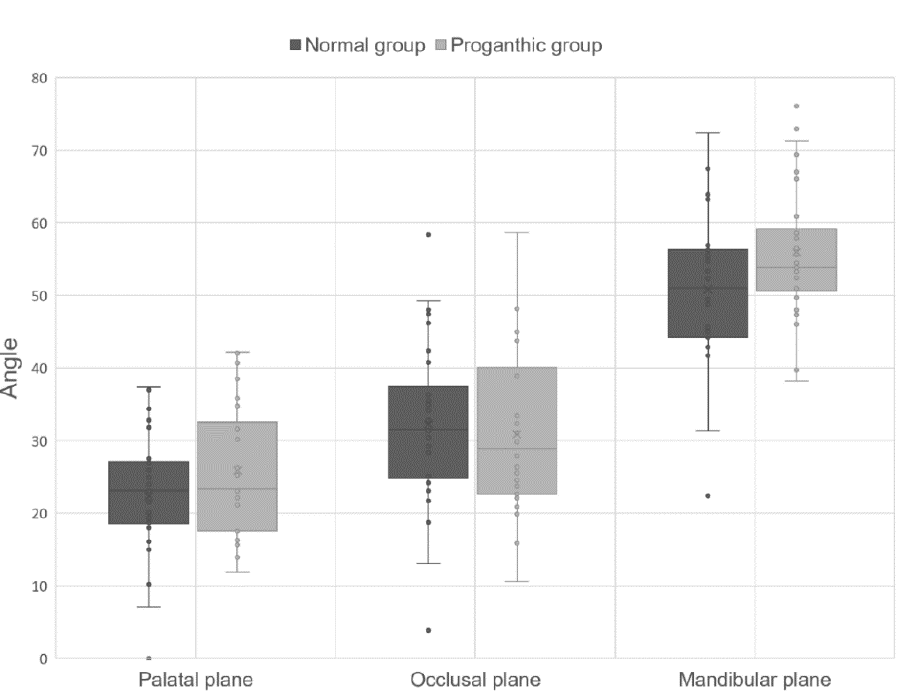
Table 1. Lateral pterygoid volume/length ratios for prognathic and normal groups.